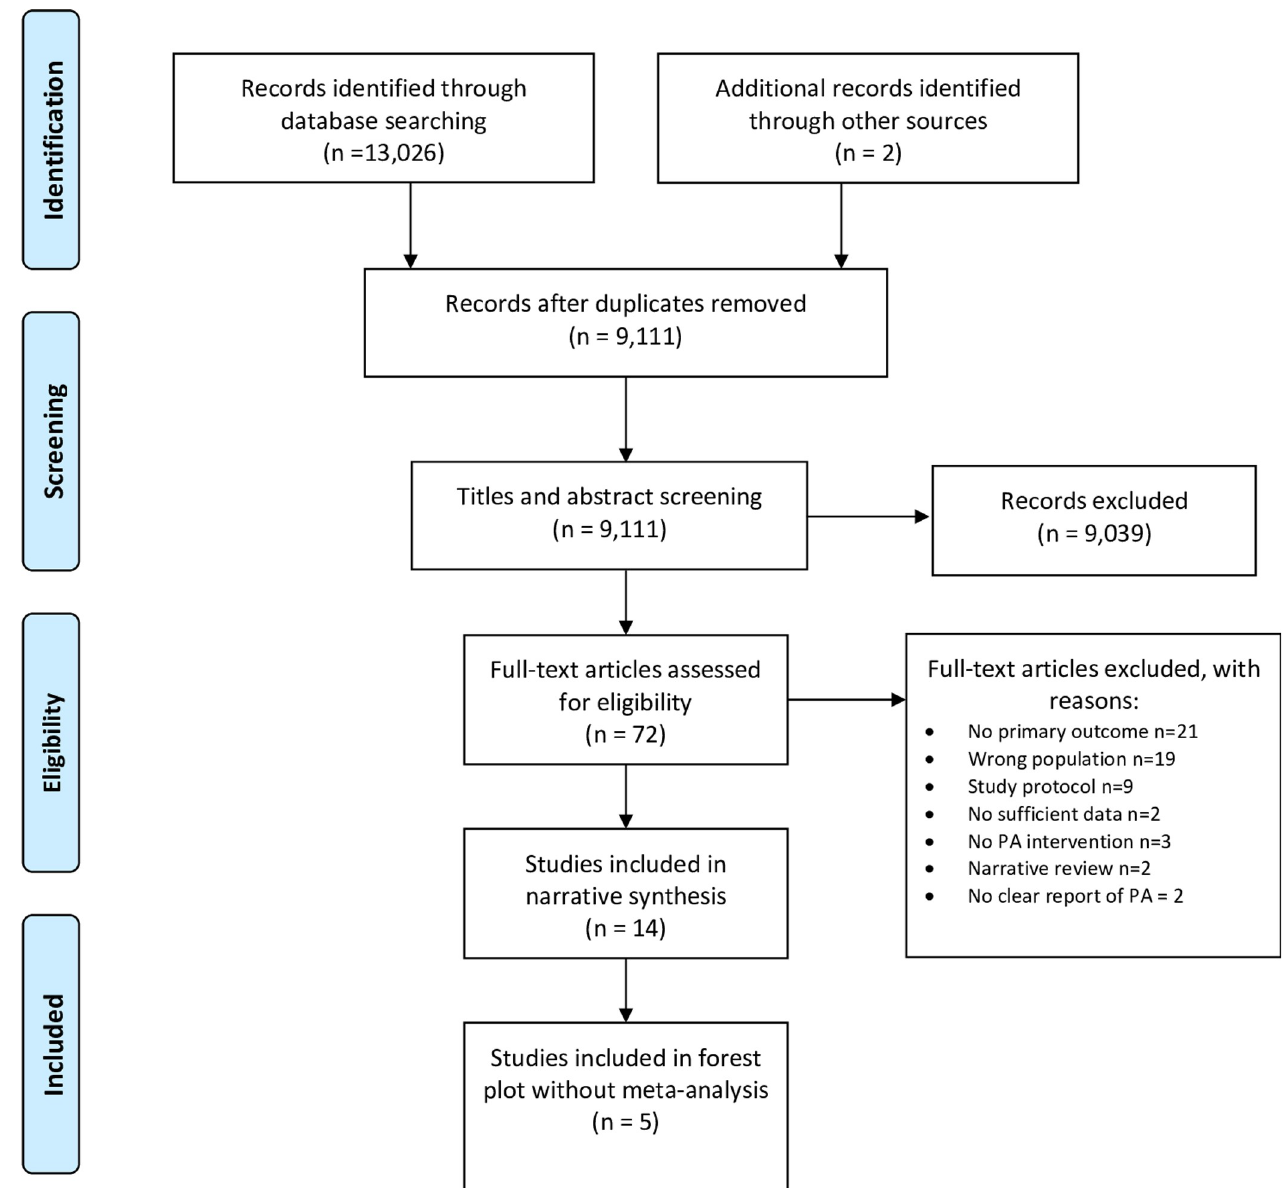
Fig 1. PRISMA flow chart for study